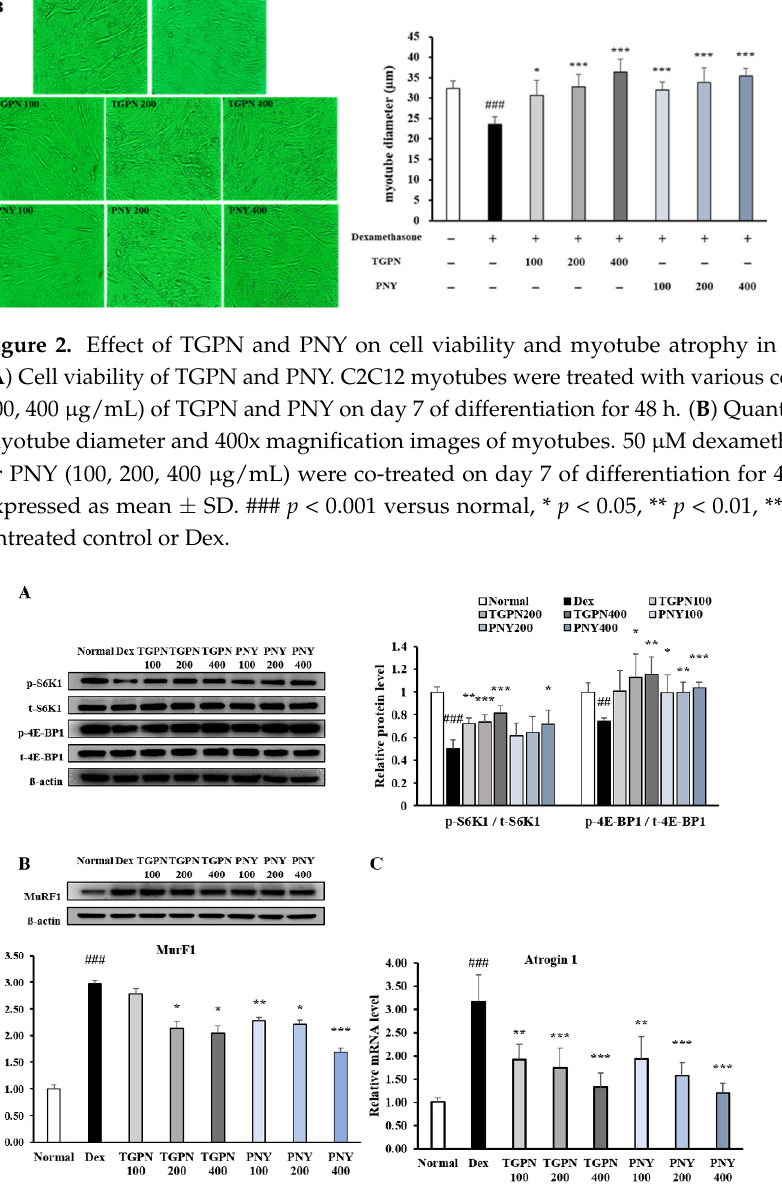
Figure 3. Effect of TGPN and PNY on expression associated with protein synthesis and degradation in C2C12 myotubes. C2C12 myotubes were co-treated with 50 µ M dexamethasone and various concentrations (100, 200, 400 µ g/mL) of TGPN and PNY on day 7 of differentiation for 48 h. The relative expression levels of ( A ) S6K1 and 4E-BP1, ( B ) MuRF1, ( C ) Atrogin-1. The protein expression levels were normalized to the β -actin. The mRNA expression level was normalized to GAPDH. The results are presented as mean ± SD. ## p < 0.01, ### p < 0.001 versus normal, * p < 0.05, ** p < 0.01, *** p < 0.001 versus Dex.